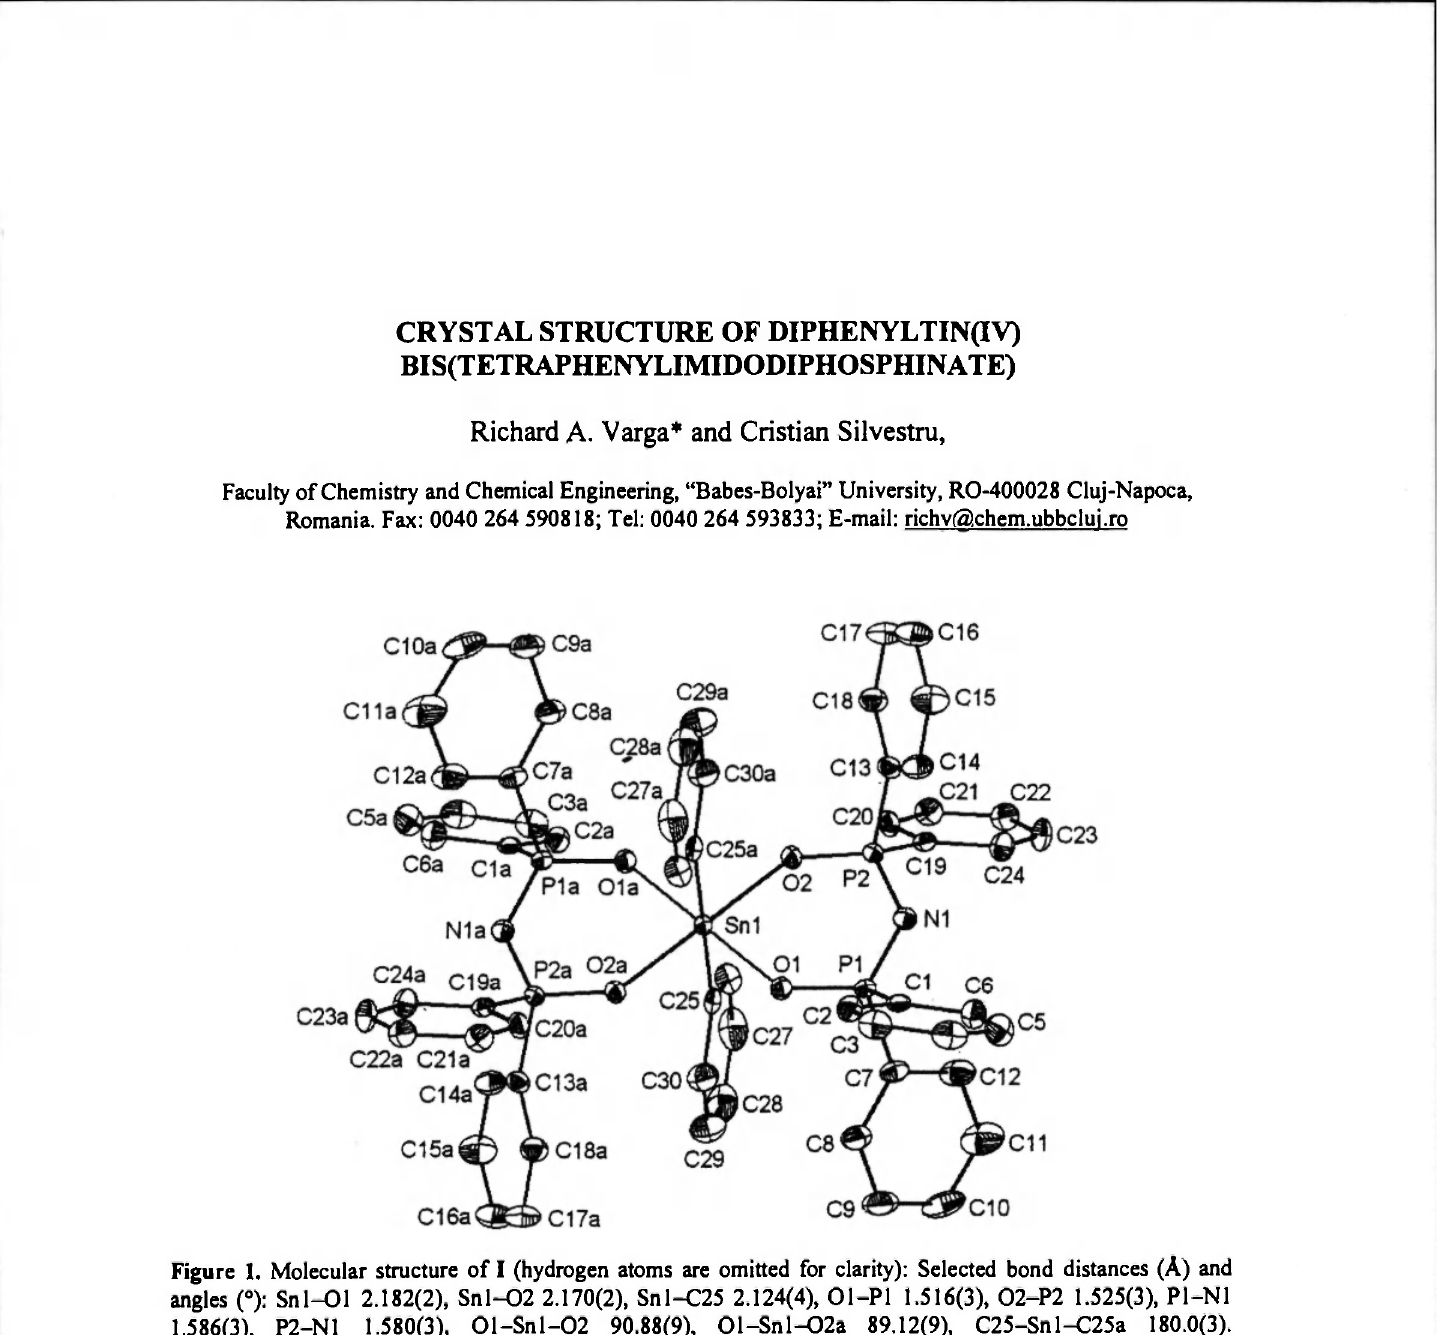
Figure 1. Molecular structure of I (hydrogen atoms are omitted for clarity): Selected bond distances (A) and angles (°): Snl-Ol 2.182(2), Snl-02 2.170(2), Snl-C25 2.124(4), Ol-Pl 1.516(3), 02-P2 1.525(3), Pl-Nl 1.586(3),